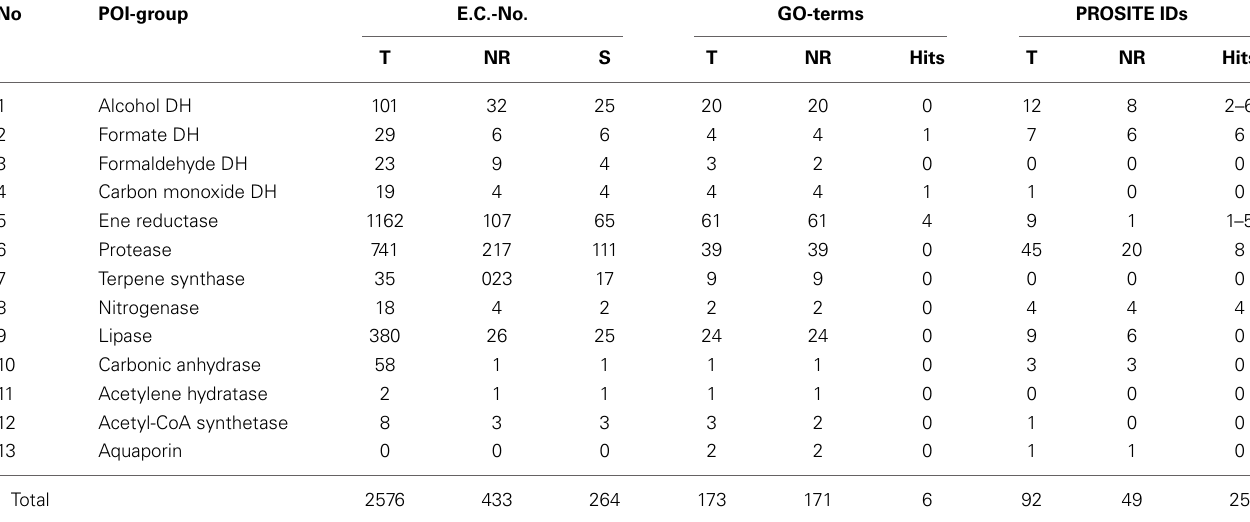
Table 4 | Stepwise overview of the conversion the 15 selected enzyme groups into non-redundant GO terms and PROSITE